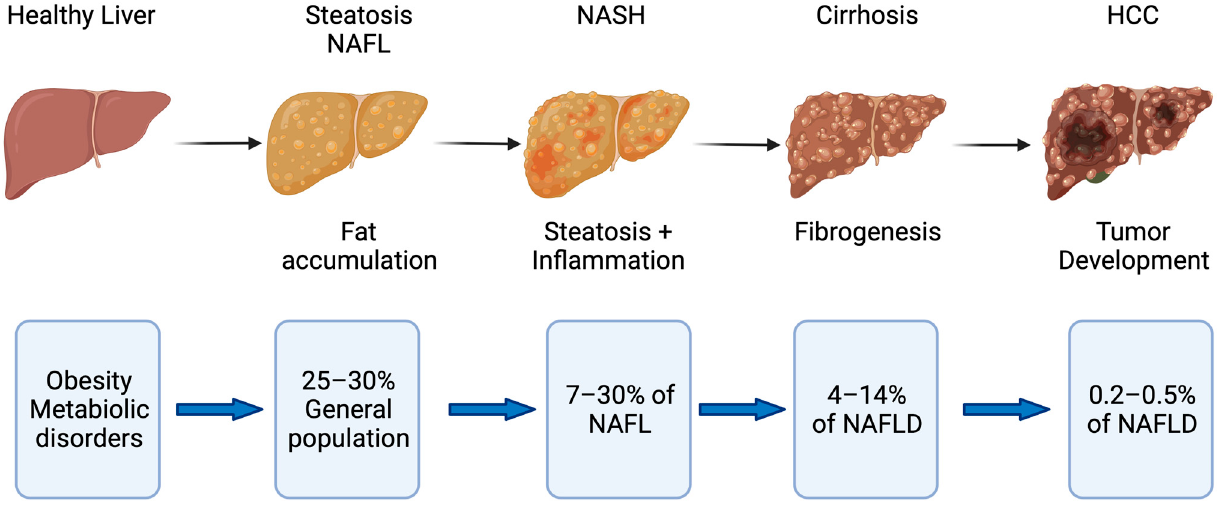
Figure 1. Disease progression in fatty liver disease. Obesity and metabolic disorders represent risk factors for NAFLD, which starts with fat accumulation in hepatocytes. Further disease progression is characterized by inflammation (NASH) and subsequent fibrogenesis leading to cirrhosis. NASH with and without cirrhosis bears the risk of developing hepatocellular carcinoma (HCC) [5,6,20]. Cellular senescence is a term describing cells which are in cell cycle arrest but remain metabolically active [21]. There is evidence showing that cellular senescence, especially in hepatocytes, may modulate fat accumulation and inflammation in patients with different stages of NAFLD [21,22]. Therefore, this review will focus on the current evidence for the role of cellular senescence in NAFLD and its effect on intercellular crosstalk as a central driver of disease progression.